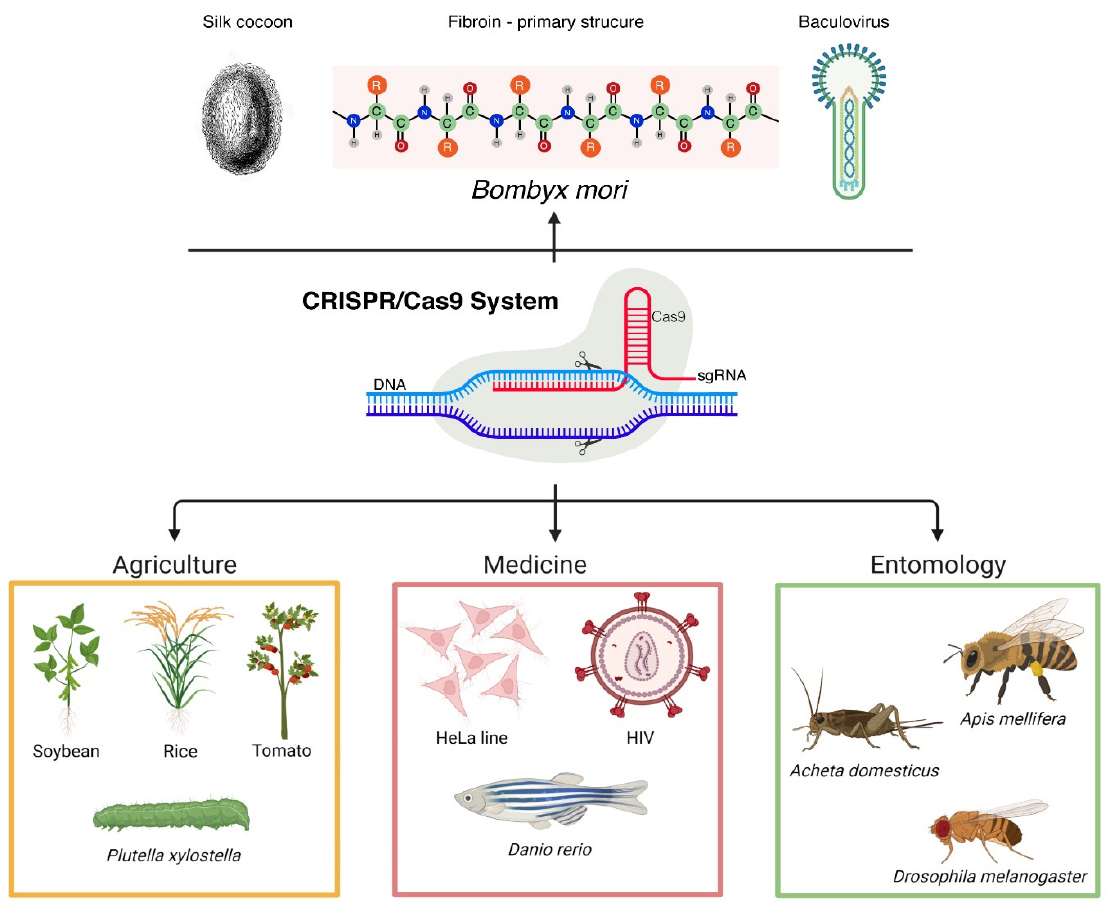
Figure 1. Schematic representation of the most important current applications of CRISPR-Cas9 in entomology, medicine, and agriculture. On top, a simplified description of CRISPR-Cas9 applicability in B. mori that is extensively described in the main text (created with BioRender.com, accessed on 2 December 2021).